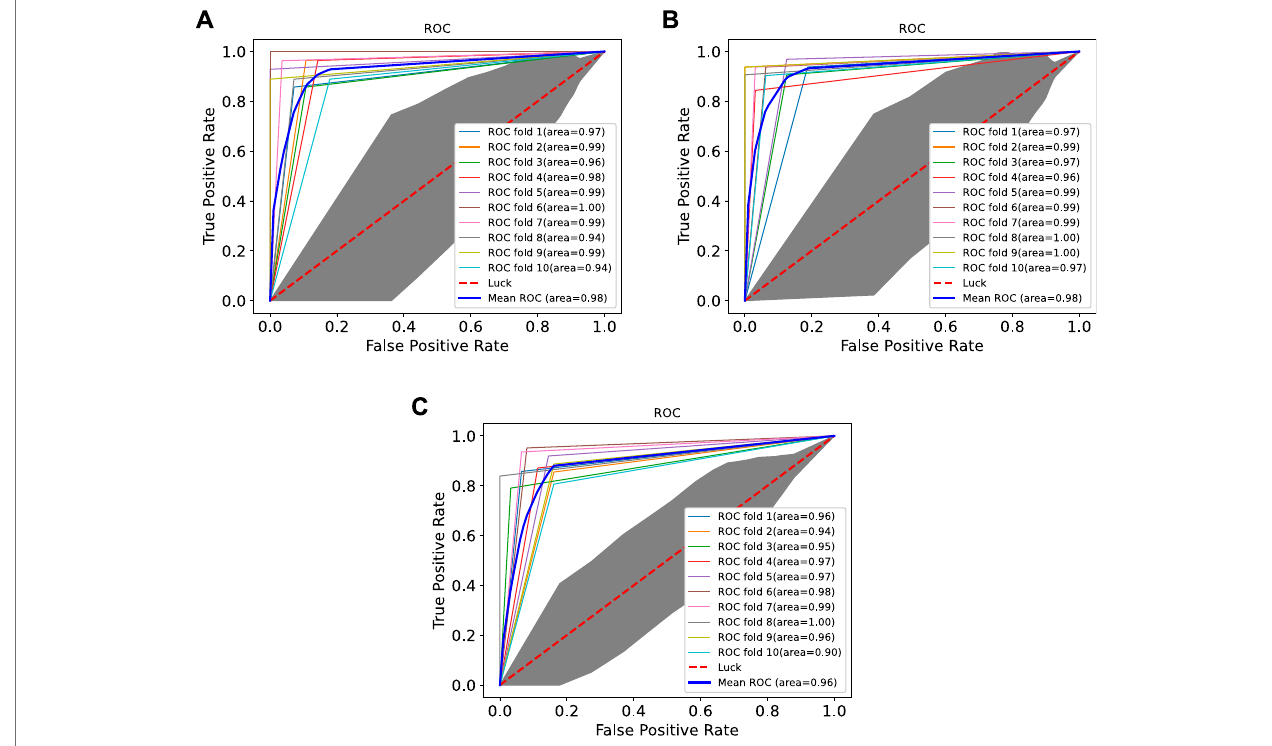
FIGURE 6 | ROC curve of GBDTLRL2D on three datasets. ROC, receiver operating characteristic.